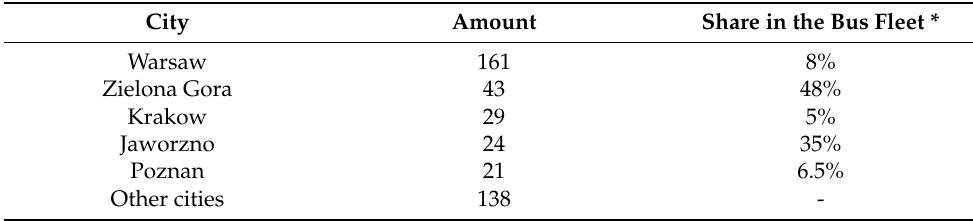
Table 3. Electric urban buses in Polish cities in December 2020.